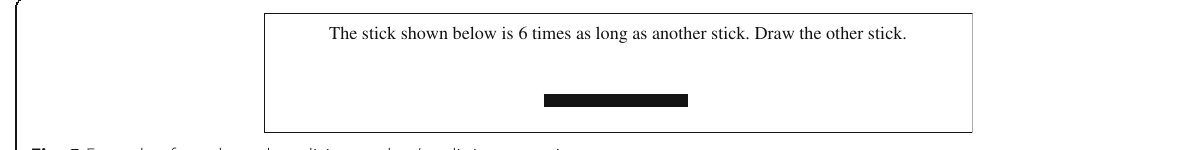
Fig. 5 Example of a task used to elicit a student ’ s splitting